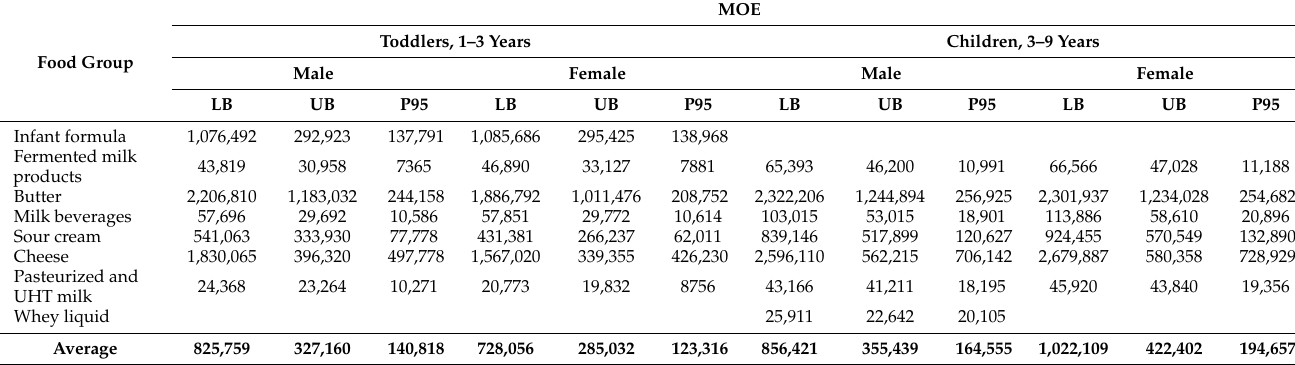
Table 5. The margin of exposure (MOE) values based on dietary exposure to AFM1 for two age categories.